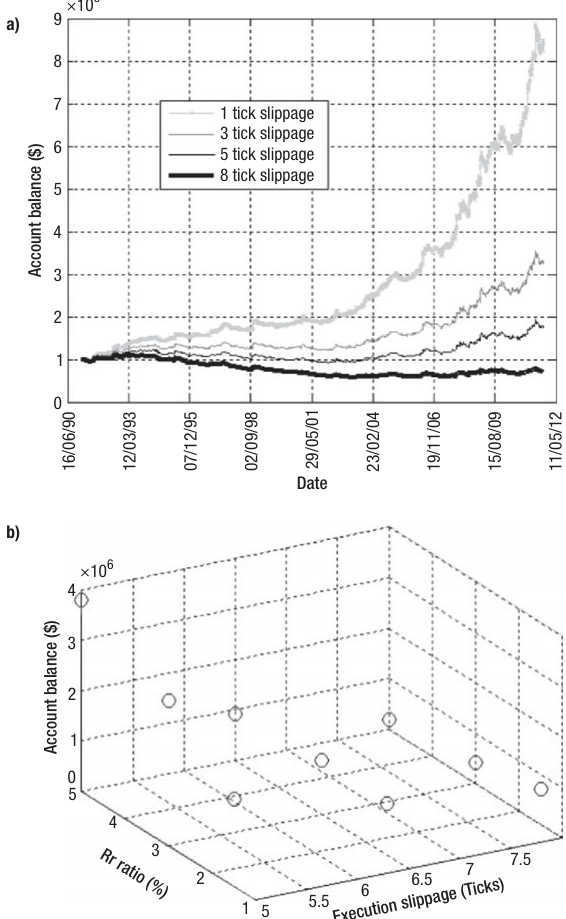
Fig. 7. Impact of trade execution slippage on the